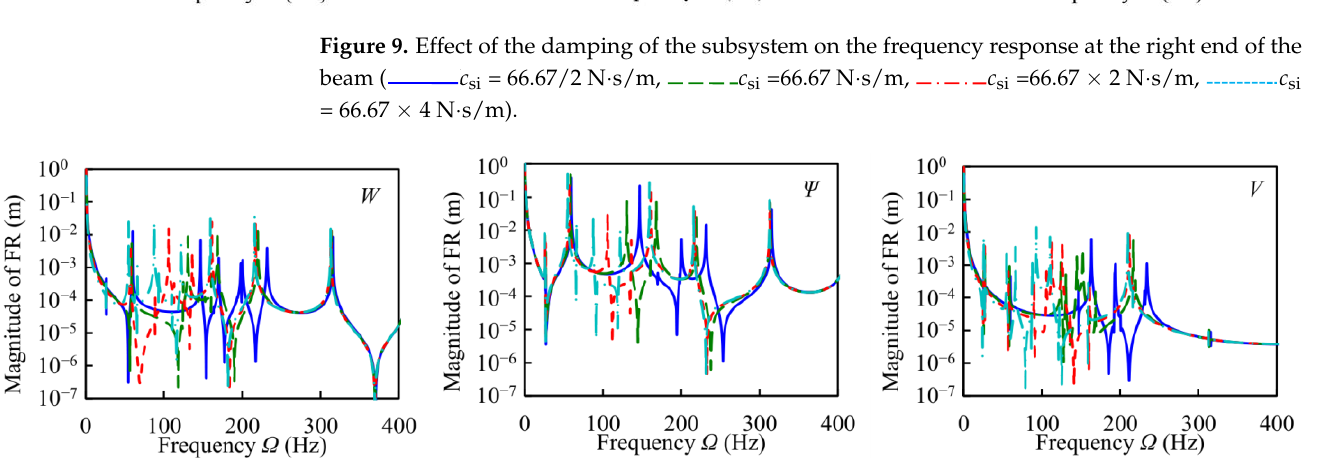
m i = 266.67/2 kg, m i = 266.67 kg, m i = 266.67 × 2 kg, m i = 266.67 × 4 kg). Figure 9. Effect of the damping of the subsystem on the frequency response at the right end of the beam ( c si = 6 6.67/2